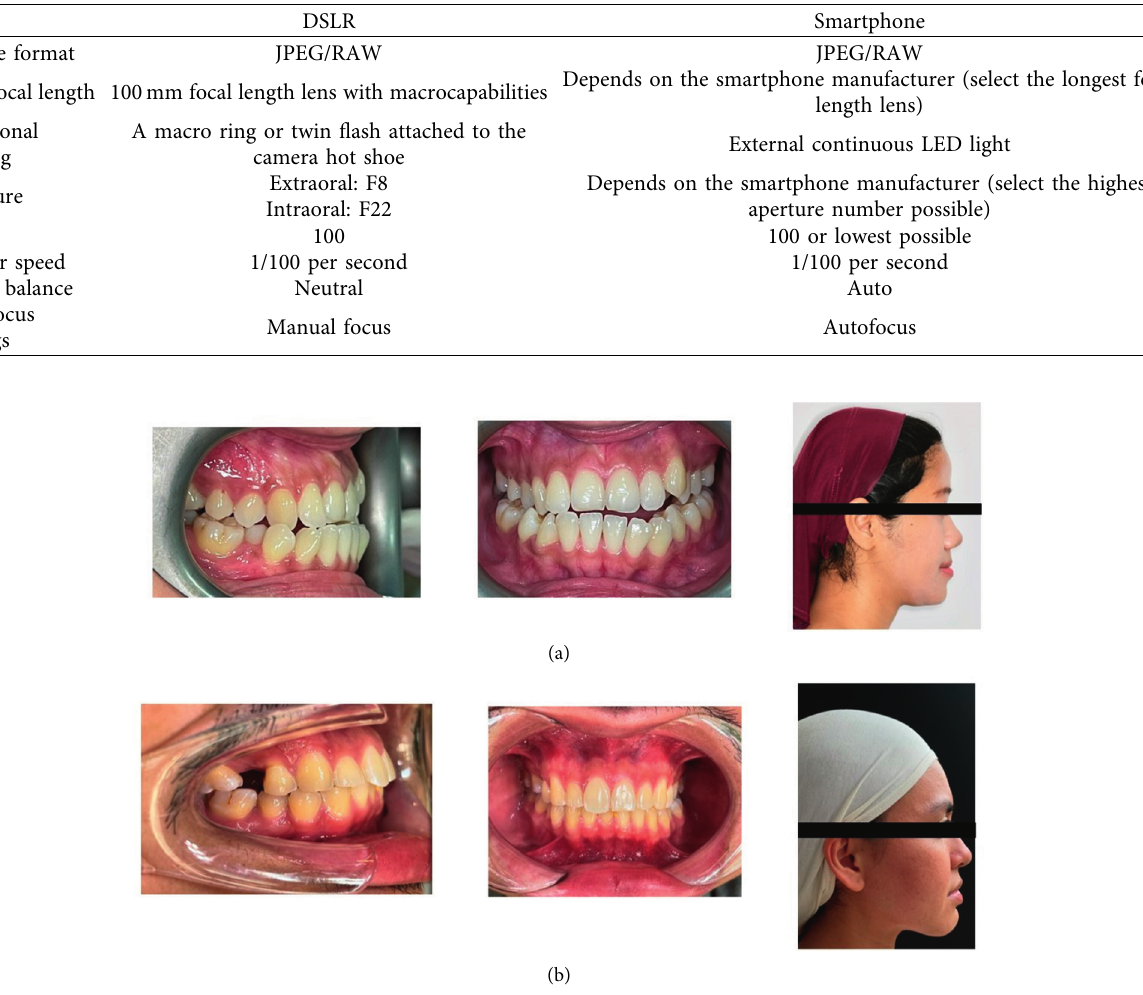
Figure 6: Photos taken (a) without the proper technique and (b) with the proper